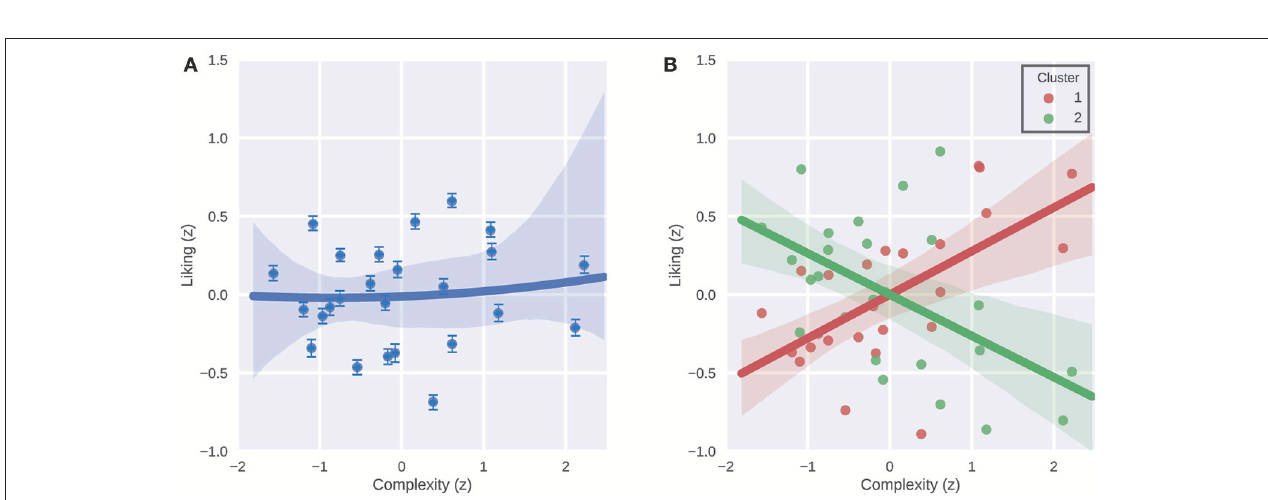
FIGURE 1 | Evaluation of clusters. (A) Comparison of average silhouette values of clustering the participants with k = [2, 10], where k = 2 appears to be a significantly better grouping of the 353 participants compared to the remaining values. (B) Silhouette value distribution of participants as they were assigned to Cluster 1 and Cluster 2, where k = 2.